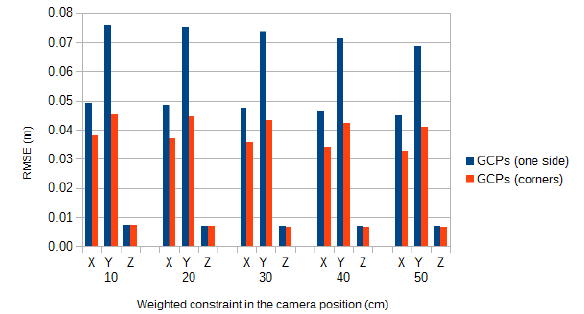
Figure 7. Sensor 2 – RMSE of GCPs resulting from the BBA considering GCPs in the corners and only on one side of the image